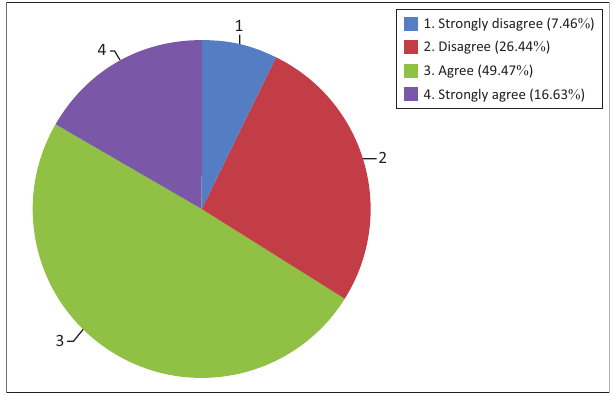
Table 6 reflects the results of the question in Section E on whether the participants believe that the intermediary programme played a part in developing their reading skills.